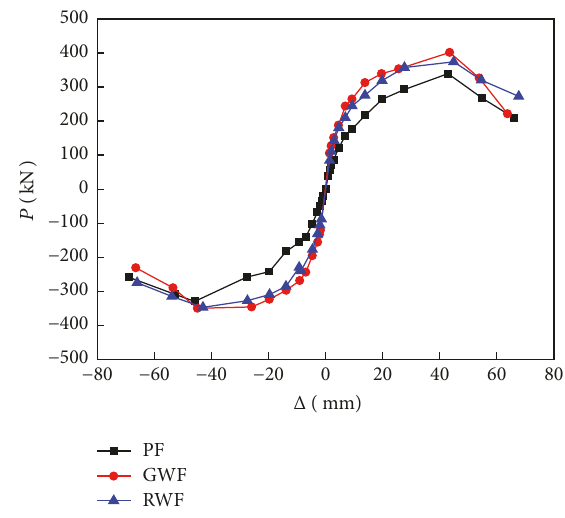
Figure 9: Skeleton curves of specimens.